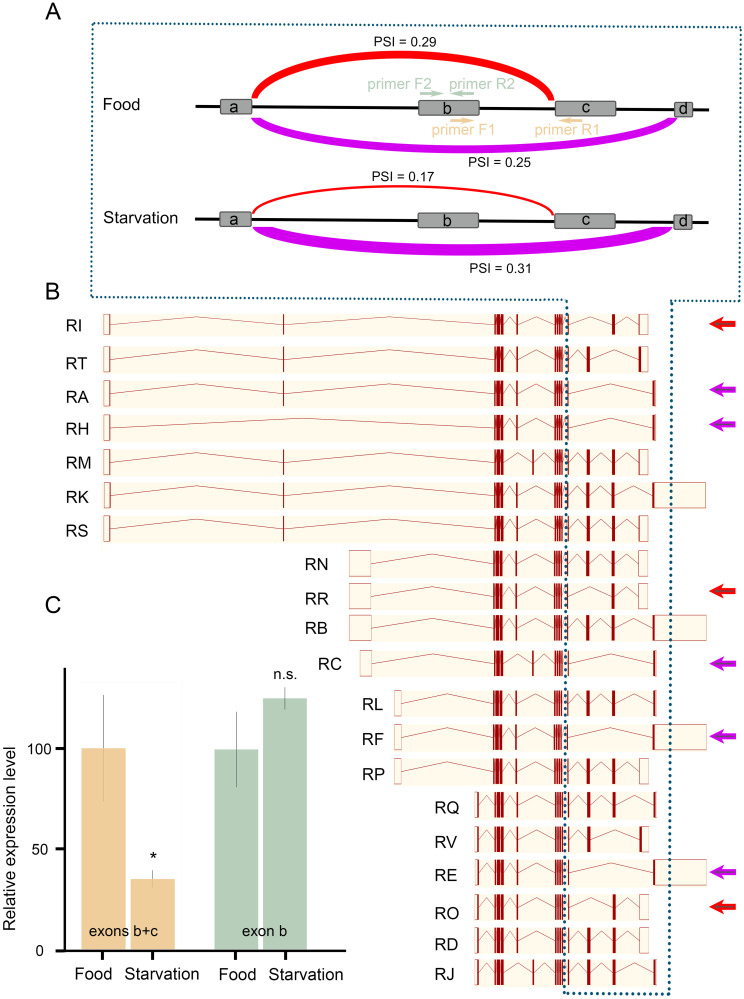
syp is alternatively spliced under starvation.(A) Differential usage of exons in syp under food and starvation conditions. Four exons involved in the alternative splicing were shown and referred to as exon a, exon b, exon c, and exon d. PSI: Percentage Sliced In. (B) Various splice variants of syp (www.flybase.org). Arrows indicate splice variants that were either downregulated (red color) or upregulated (purple) under starvation. (C) Relative expression of targeted exons measured by qPCR. The targeted locations of each pair of primers were indicated in panel A. * P < 0.05, n.s.: P > 0.05, unpaired t-test, n = 4 per condition. Error bars represent SEM.